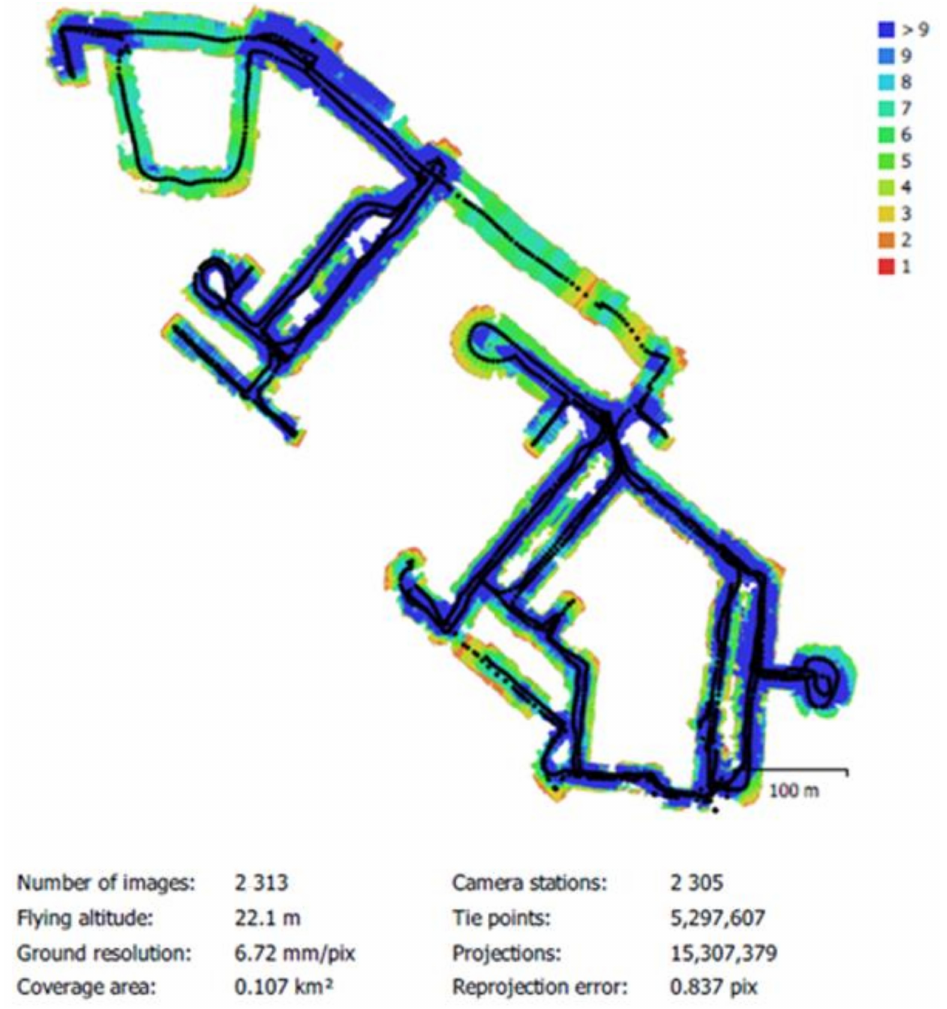
Figure 2. Camera locations and image overlap with